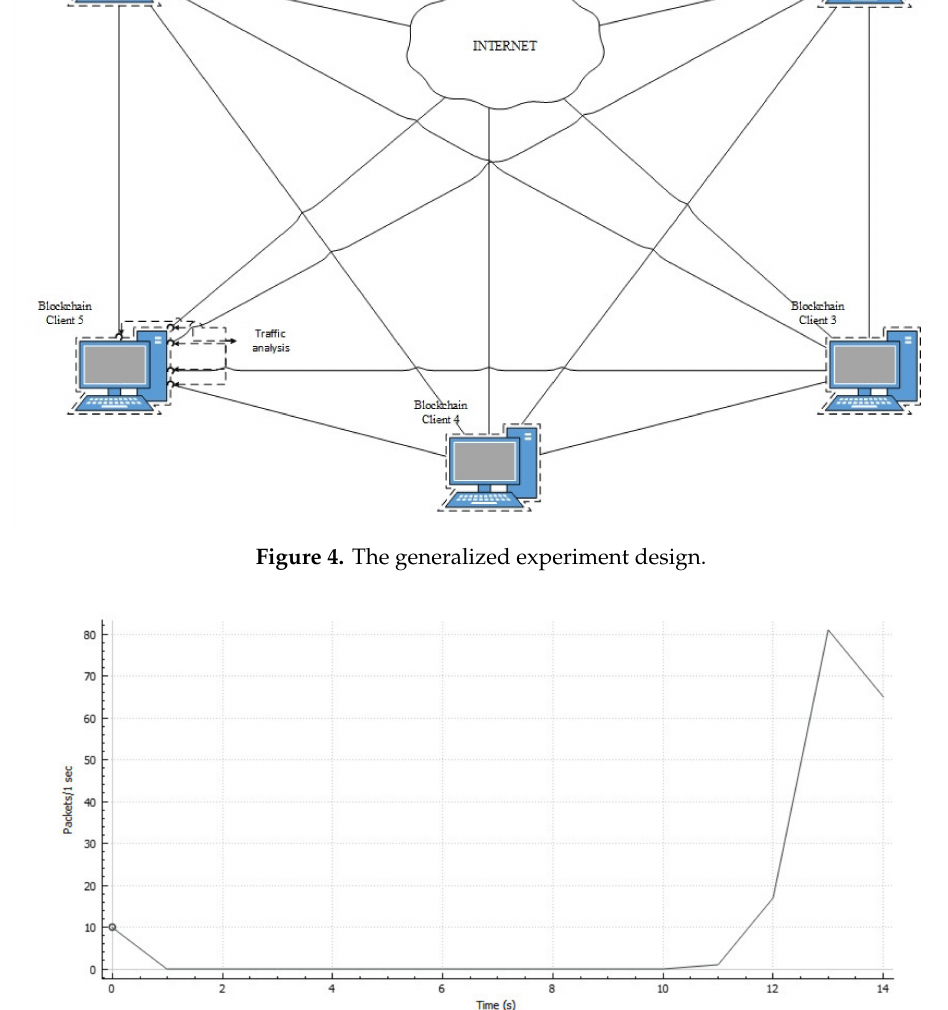
Figure 5. A diagram of the packet tra ffi c load upon initial synchronization with the network.